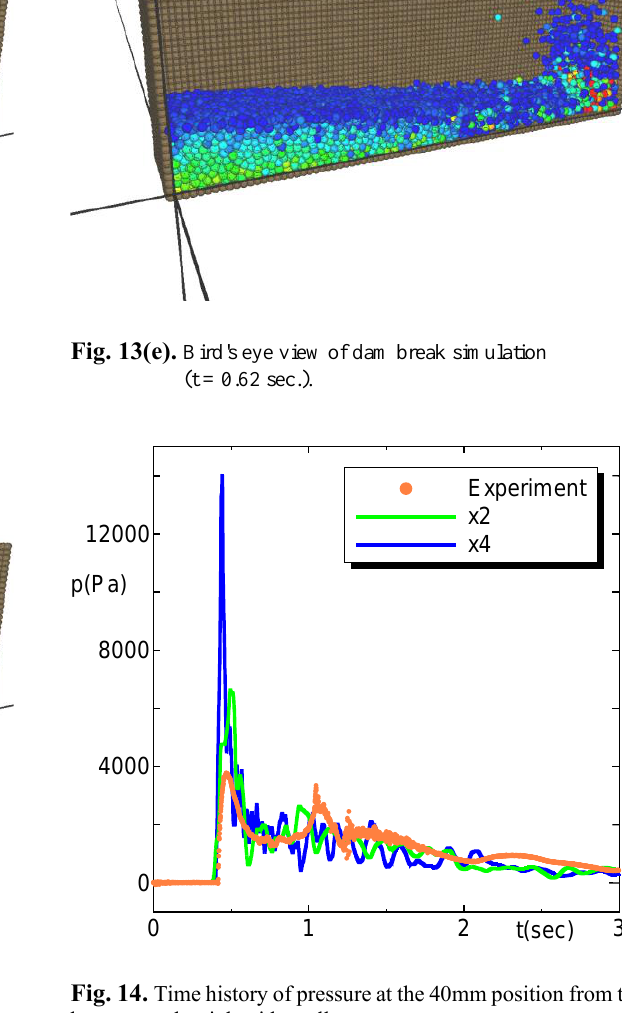
Fig. 14. Time history of pressure at the 40mm position from the bottom on the right side